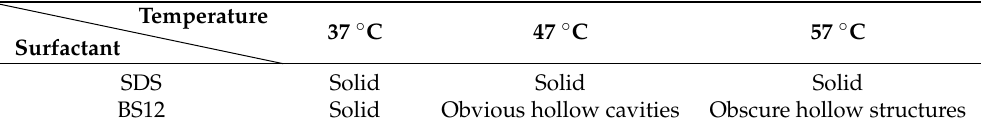
Table 1. The influence of surfactant type and temperature on crystal